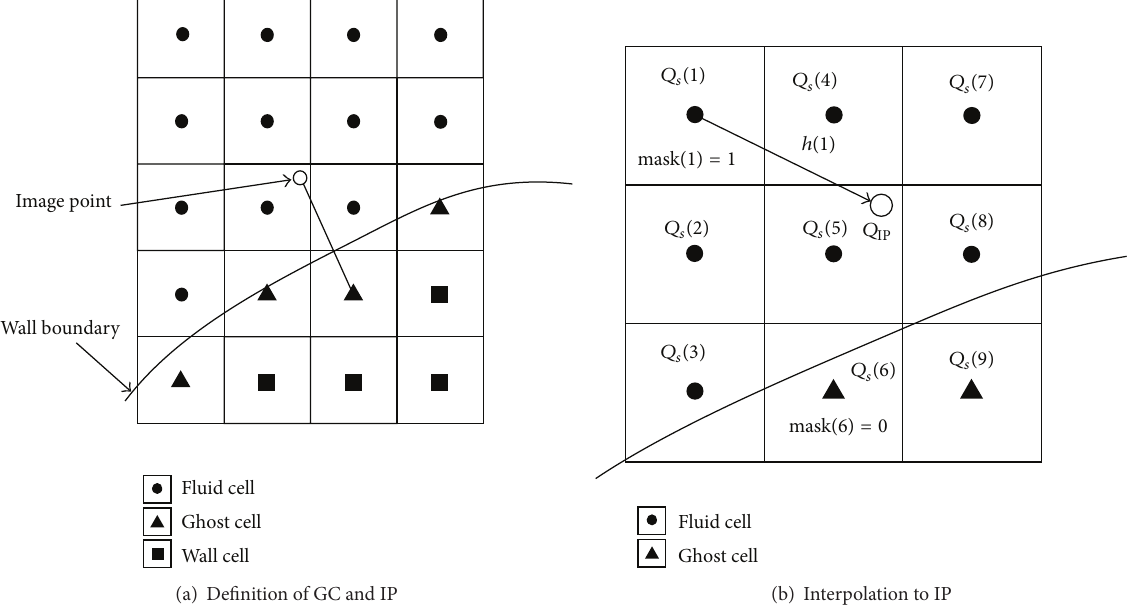
Figure 3: The immersed boundary method (IBM) using an image point (IP) based on a ghost cell (GC).